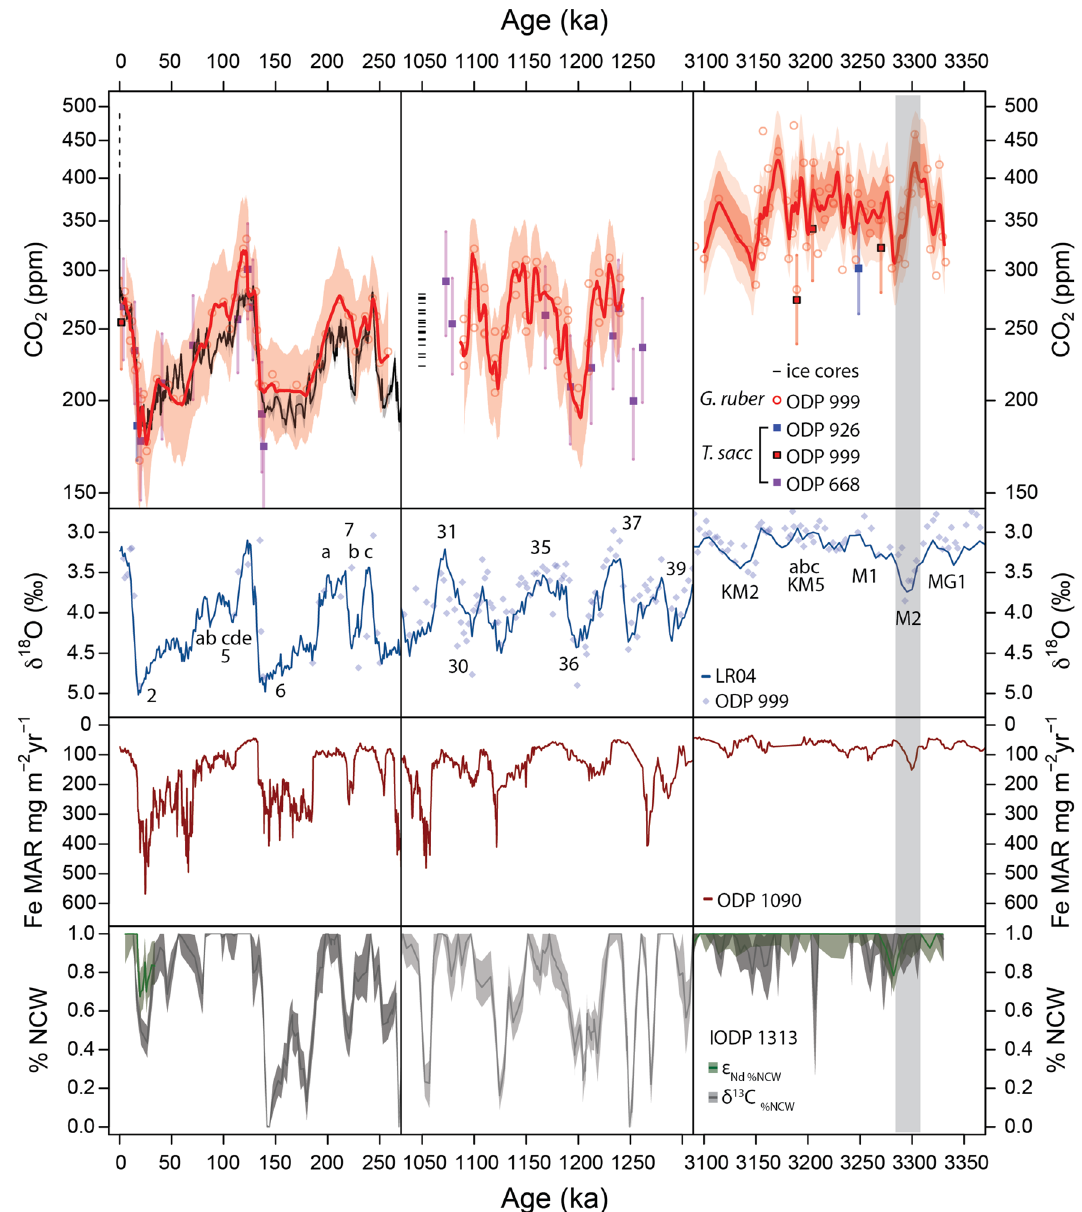
Figure 2. Top panel: Red circles and lines show δ 11 B-derived CO 2 data from Globigerinoides ruber at ODP Site 999 (this study and Martinez-Boti et al. 13 , Chalk et al. 18 ), red squares are Trilobatus sacculifer at ODP 999 (this study and Seki et al. 14 ), purple squares are T. sacculifer from ODP 668 (Honisch et al. 23 ) and blue squares are T. sacculifer from ODP 926 (Sosdian et al. 20 ). Black solid line shows ice core-derived CO 2 from ref. 58 . Left; Late Pleistocene CO 2 from boron isotopes 14,18,23,52 and ice core data. Also shown are CO 2 projections in line with RCP8.5 at current emission rates to the year 2040 (black broken line). Middle column; MPT CO 2 estimates 18,23 including disturbed ice estimates 24,25 (Note: age adjusted for scale). Right; mPWP estimates of CO 2 (this study combined with Martinez-Boti et al. 13 ), new data from T. sacculifer is shown in red squares and shows no offset from G. ruber estimates. Second panel: Time periods as above, LR04 and ODP 999 δ 18 O from C. wuellerstorfi 18,19,53 . Third panel: Iron mass accumulation rate from the Southern Atlantic ODP Site 1090 28 . Fourth panel: % Northern Component Water (NCW) estimated from δ 13 C in benthic foraminifera (grey) and ɛ Nd from fish debris (dark green) in the deep North Atlantic (core U1313 31 ). Note the lag of ocean circulation and CO 2 relative to the M2 glaciation 31